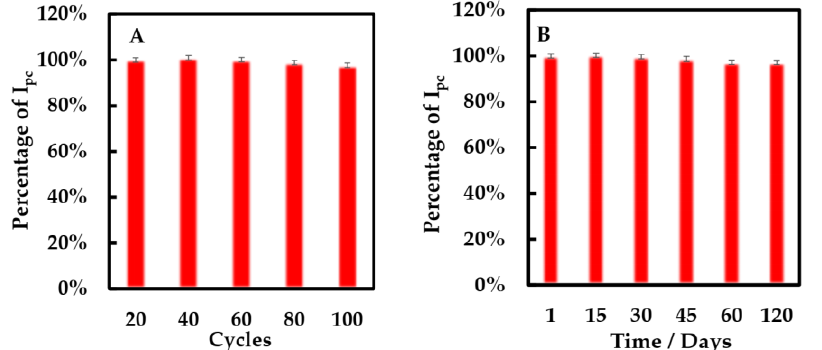
Figure 10. Percentage of cathodic peak current of NF-GLA/MWCNTs-BSA-HFs-GOD/GCE versus ( A ) cycles and ( B ) storage time (days) in 50 mM phosphate-buffered solution (pH 6) at a scan rate of 0.05 V ‧ s −1 .